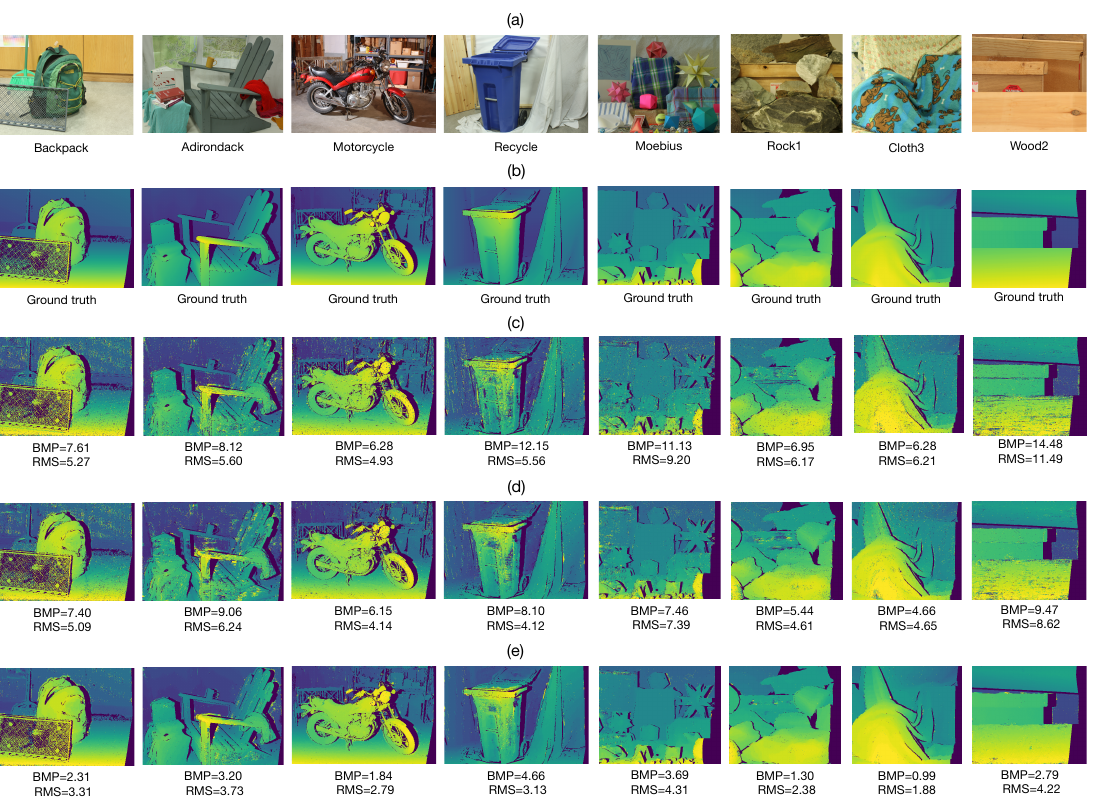
Figure 4. Disparity estimation results for non-occluded image regions. ( a ) Right input stereo image. ( b ) Ground truth disparity map of non-occluded image regions. Estimated disparity maps of non- occluded image regions, obtained with: ( c ) IWCT, ( d ) AD-C and ( e ) Proposed